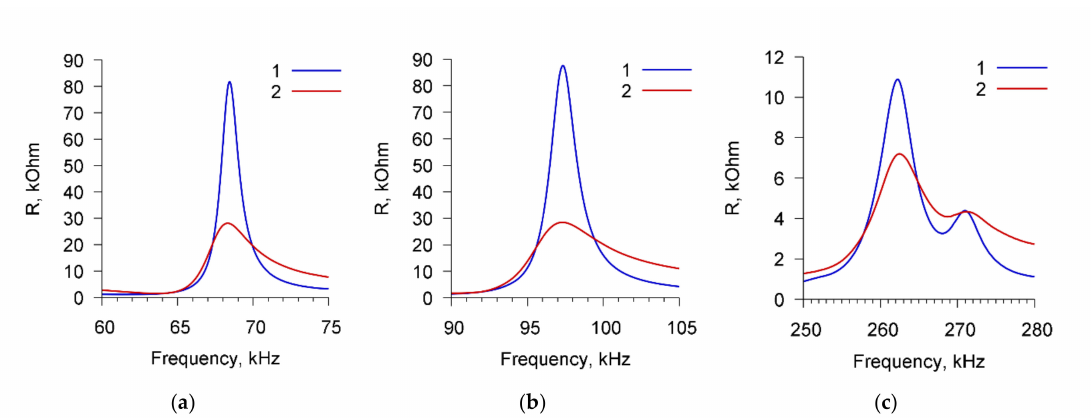
Figure 3. The frequency dependencies of the real part of the electrical impedance of PZT resonator with container loaded by A. brasilense Sp7 suspension before (curve 1) and after (curve 2) adding the specific Abs. The cell concentration was 10 3 cells / mL, the concentration of Abs was 4 µ g / mL. ( a ) Peak near 68.7 kHz, ( b ) peak near 97.8 kHz, ( c ) peak near 264